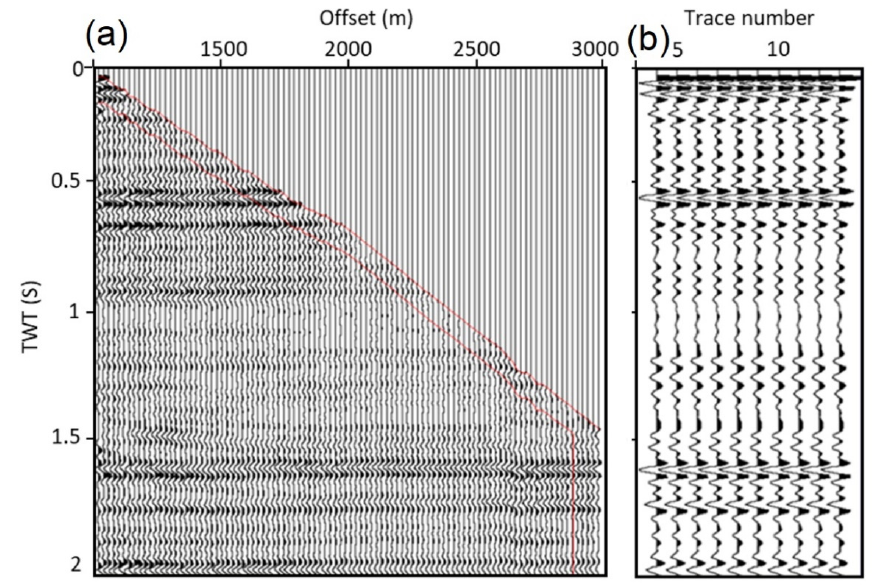
Figure 12. ( a ) The flattened upgoing wavefield. The red narrow corridor corresponds to the outside corridor stack, containing 10 traces. The receivers on the VSP in the borehole are starting from 1000 m to 3000 m. ( b ) The corridor stack that consists of 10 traces corresponding to the red narrow corri-